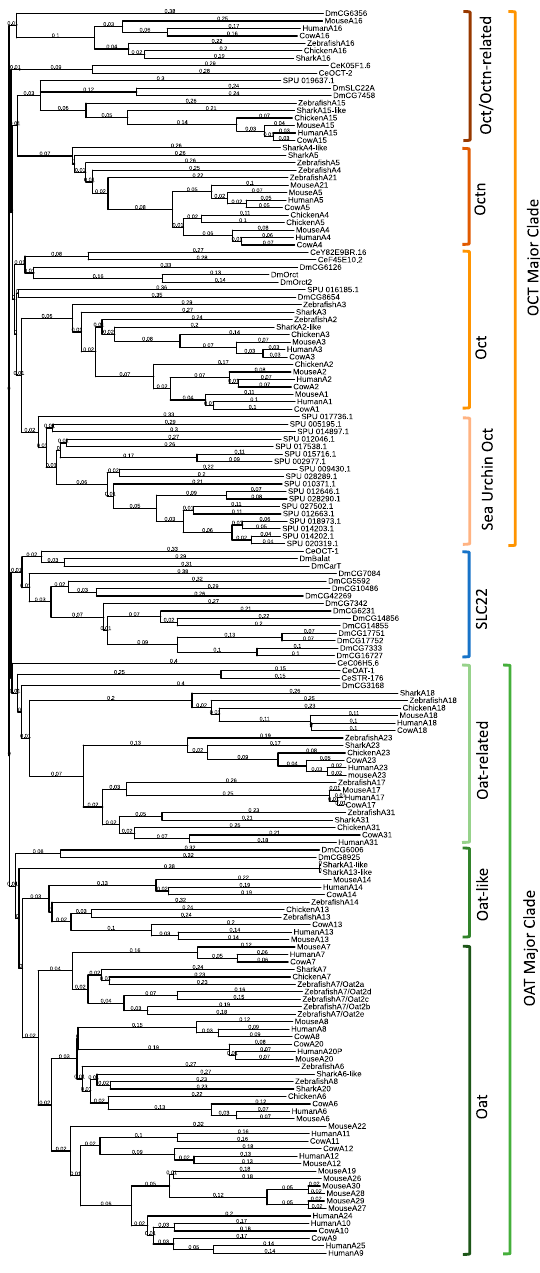
Figure 1. Guide tree of the SLC22 Transporter Family Using 167 Sequences. Sequences from human, mouse, cow, chicken, shark, zebrafish, sea urchin (SPU), C. elegans (Ce), and fruit fly (Dm) were aligned and tree was generated using Clustal Omega (using default parameters). The tree was viewed using Interactive Tree of Life (iTOL). Branch length values are calculated via the Kimura method [44]. Large sea urchin expansion within the Oct Major clade is labeled “Sea Urchin Oct”. Sequences that fall between the Oat Major Clade (green) and Oct Major Clade (orange) are denoted as SLC22 (blue).